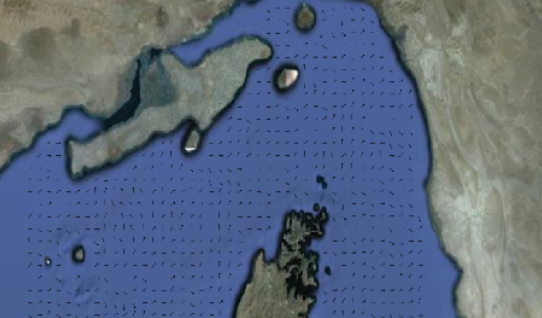
Figure 5. Surface current vector field Over the Coastal area of Hormuz Strait in detailed view and high resolution and vector